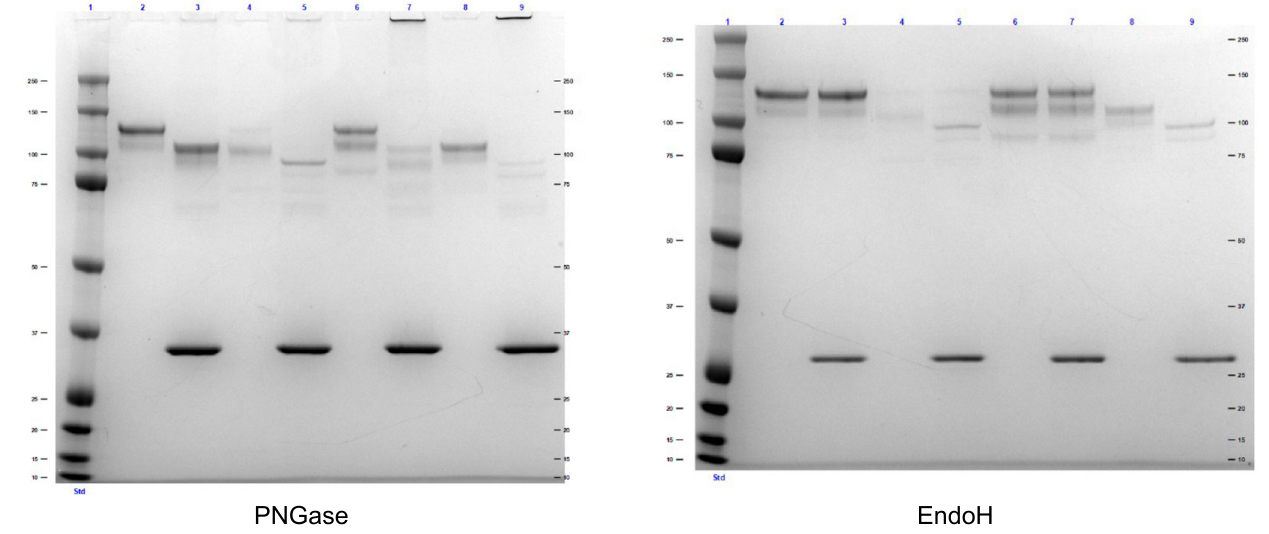
Figure A2. UncroppedCoomassie-stainedgel shownin Figure 5 .